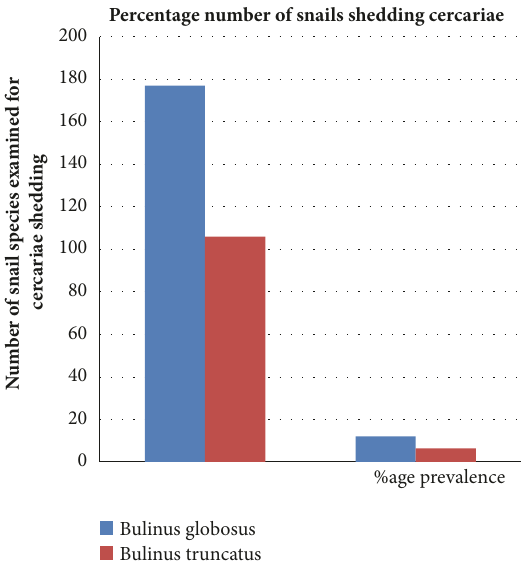
Figure 5: Percentage output of cercariae shedding by different snail species.